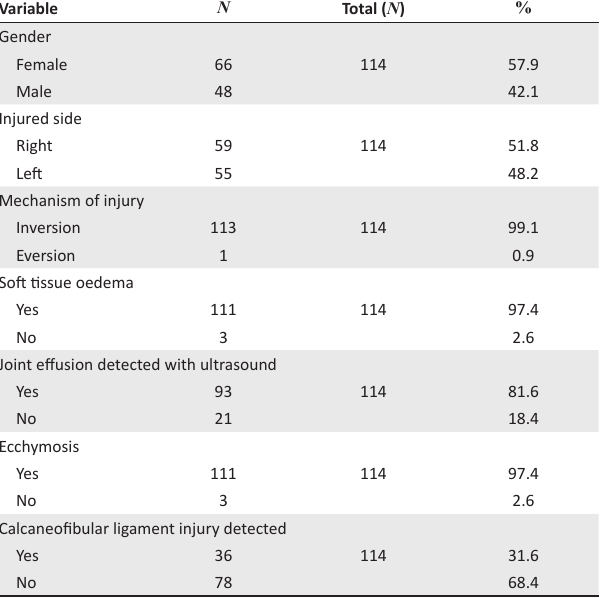
FIGURE 9: (a) Dynamic evaluation of an injured anterior tibiofibular ligament with a clear space measurement of 6 mm in neutral (N), (b) 4.2 mm in internal rotation (IR) and (c) 9.3 mm in external rotation (ER). The haematoma accompanying the injury is easily seen in the ER position (yellow arrow). TABLE 2: Characteristics of the study population presented as frequencies and percentages.